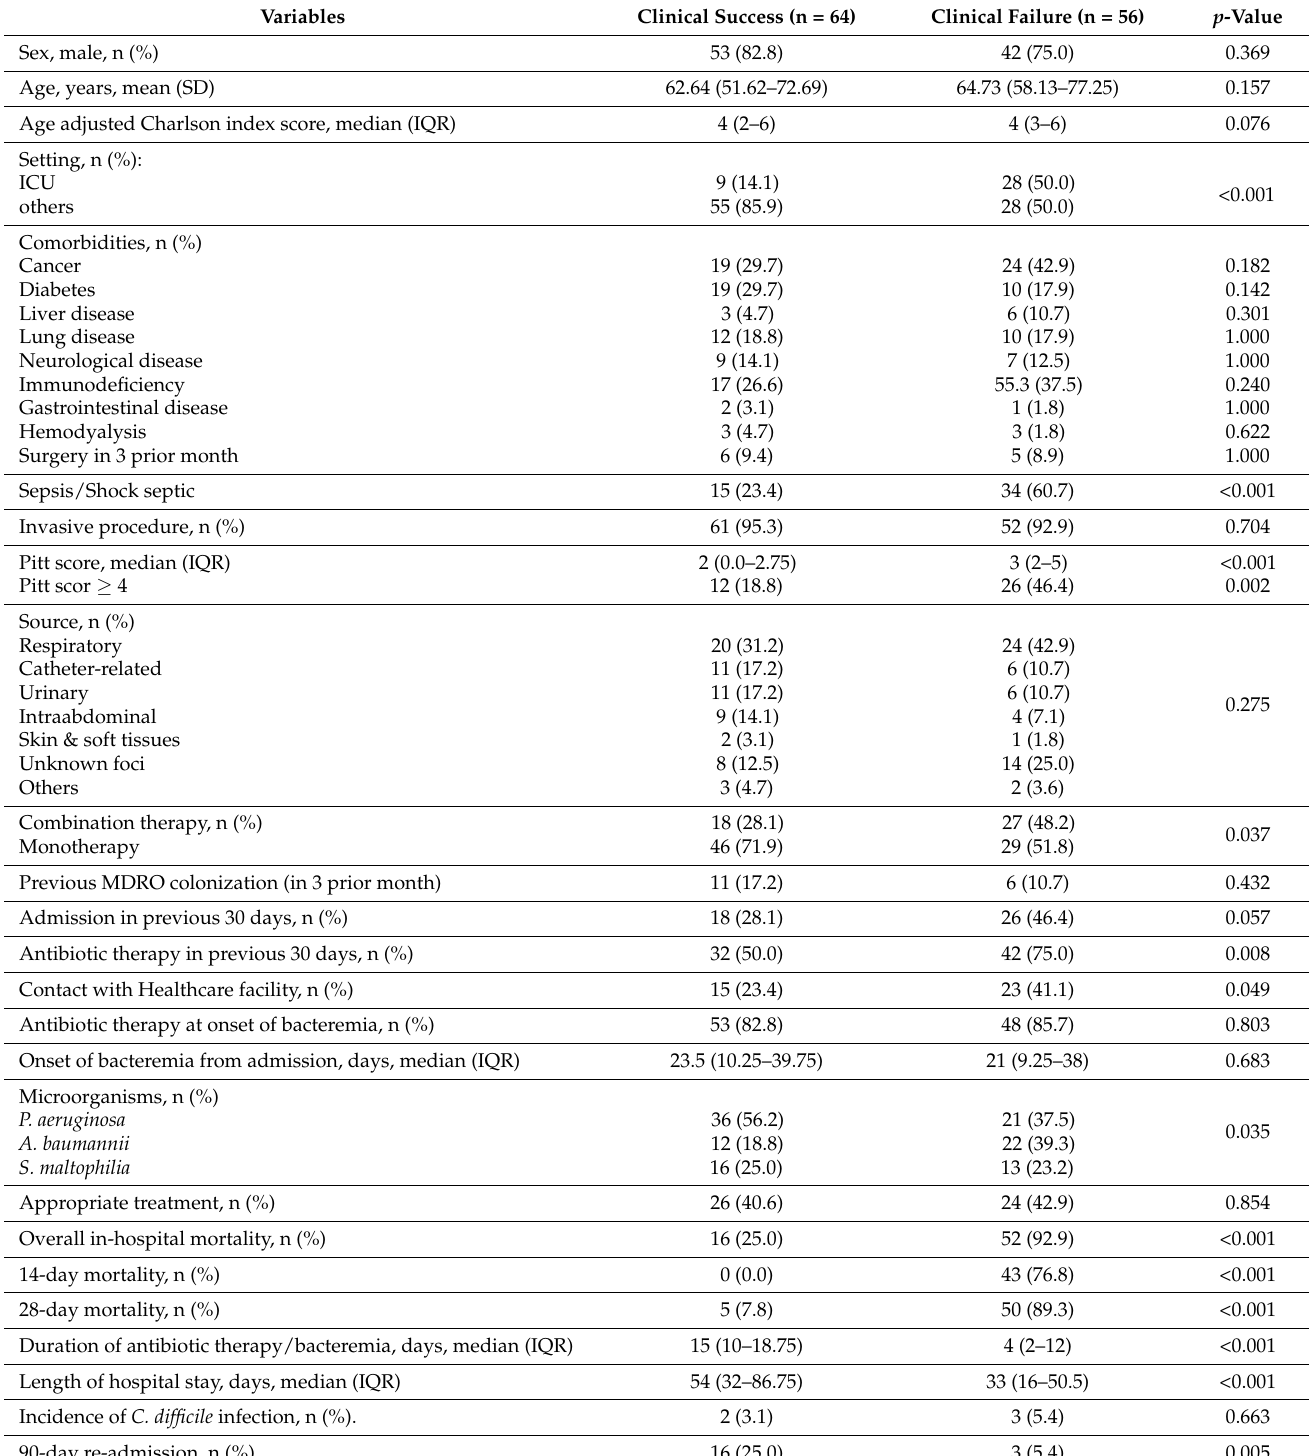
Table 4. Bivariate analysis of factors associated with primary